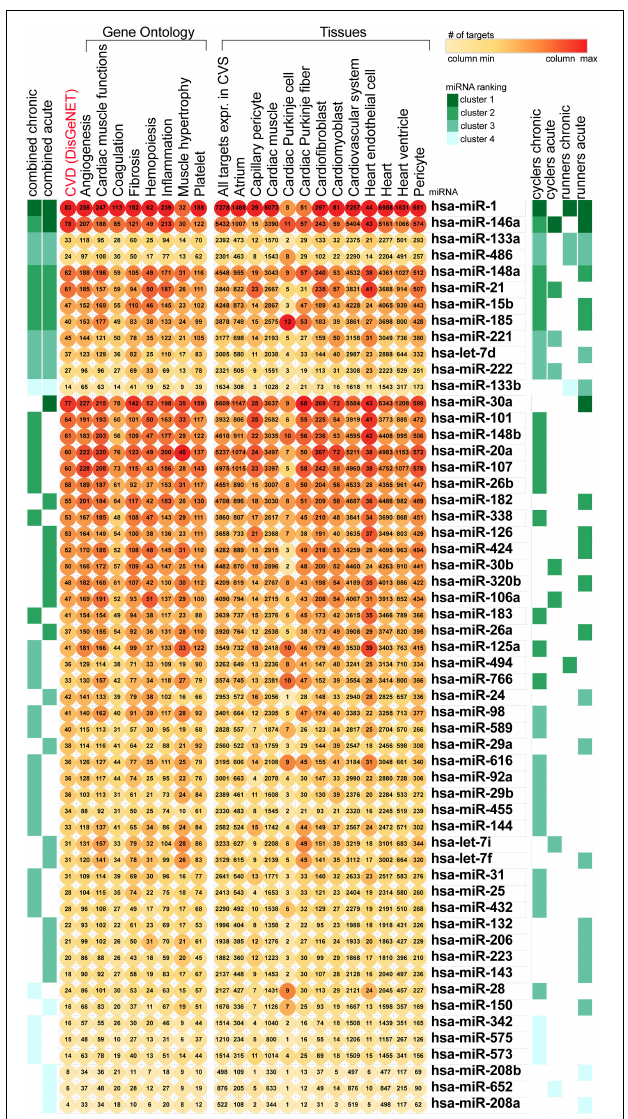
FIGURE 1 | Ranking of the training-related miRNAs based on the number of targets associated with heart function. miRNA, miR, microRNA; CVS, cardiovascular system; CVD, cardiovascular disease.